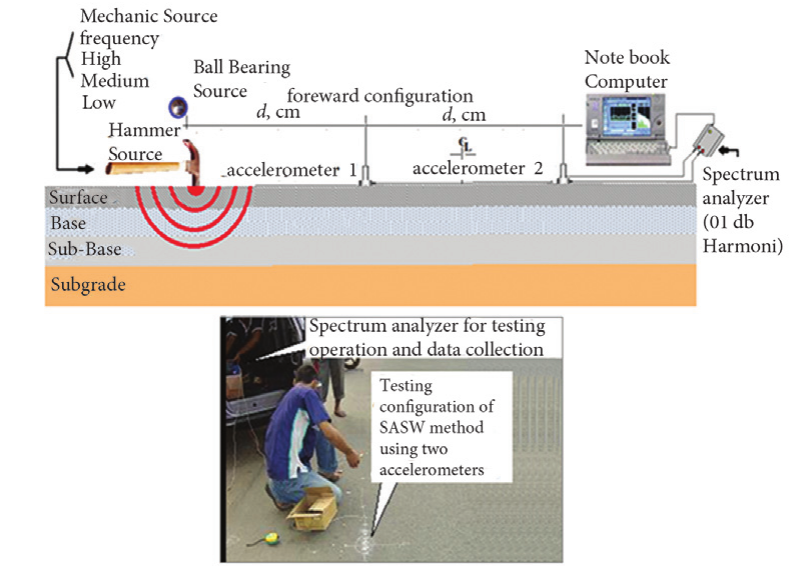
fig. 3. SASW experimental set